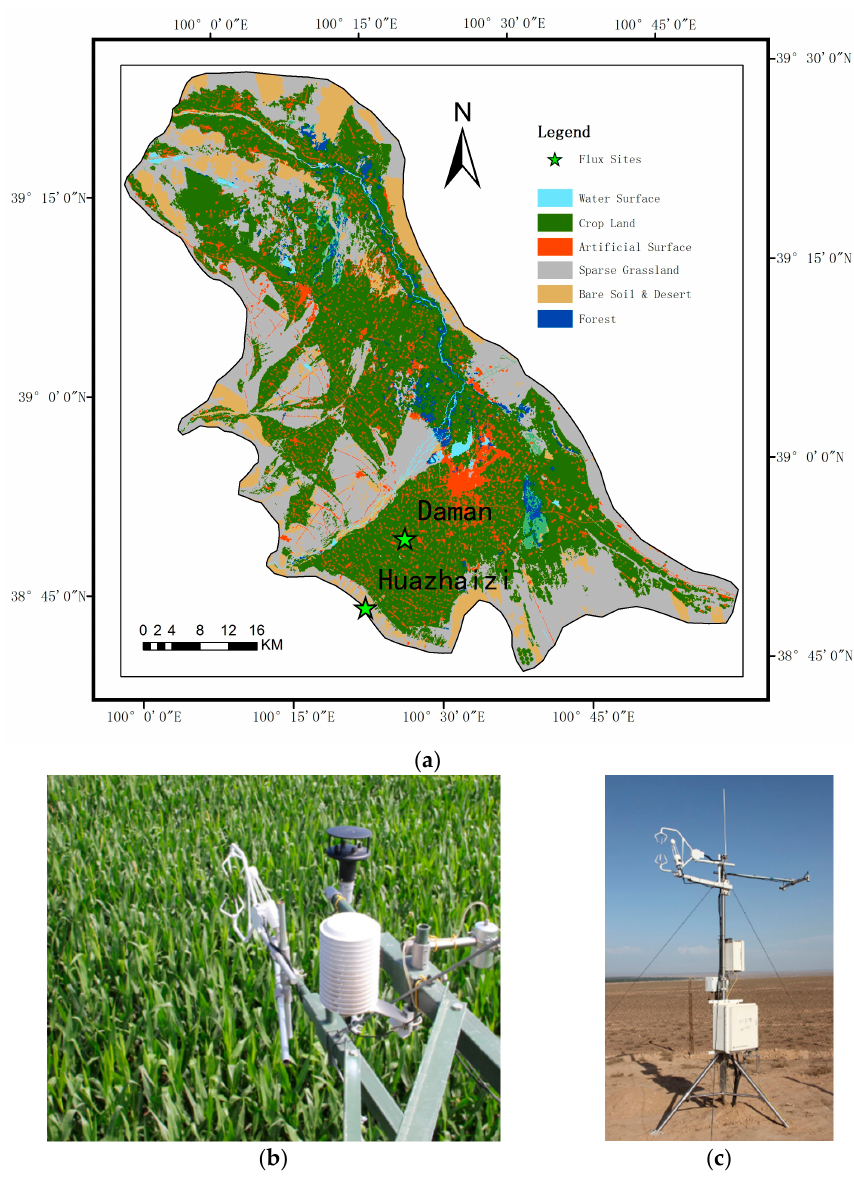
Figure 1. ( a ) land cover map of the middle reach of the Heihe Basin in 2013, ( b ) photograph of the eddy covariance (EC) site at Daman, ( c ) photograph of the EC site at Huanzhaizi.